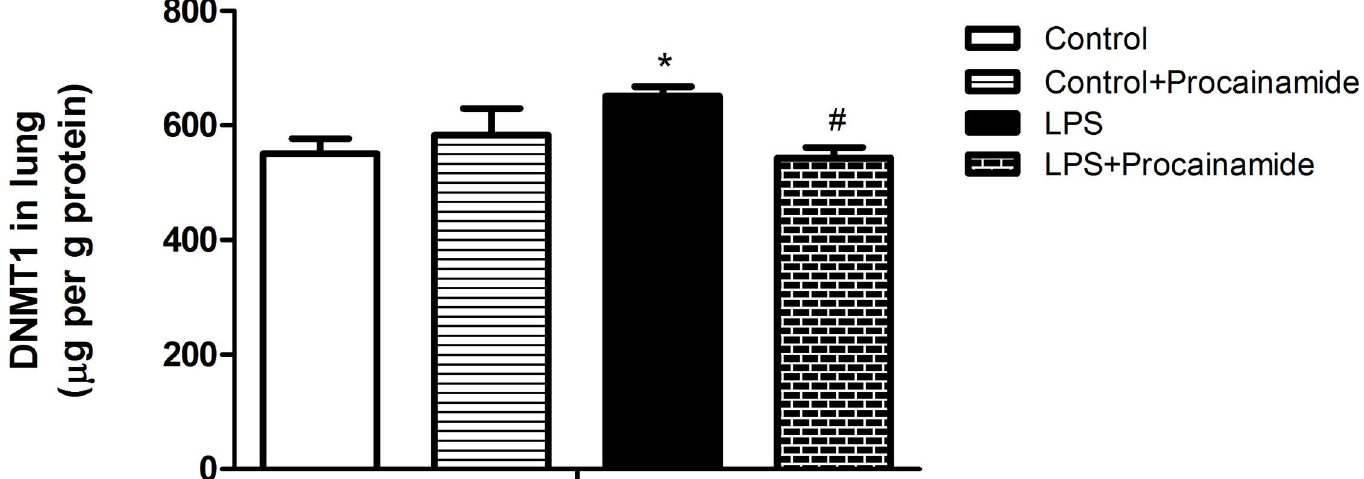
Fig 8. Effects of procainamide on DNMT1 levels in the lungs obtained from different groups of animals. Depicted are changes in lung DNMT1 levels at the end of experiment (at 6 h) in different groups of rats that received saline at time 0 (Control, n = 4), received salineas in Control group and then received procainamide at 1 h (Control + Procainamide, n = 4), received LPS at time 0 (LPS, n = 7), and received LPS at time 0 and then received procainamide at 1 h (LPS + Procainamide, n = 7). Data are expressed as mean ± SEM. * P < 0.05, all versus Control rats; # P < 0.05, with versus without procainamide in LPS